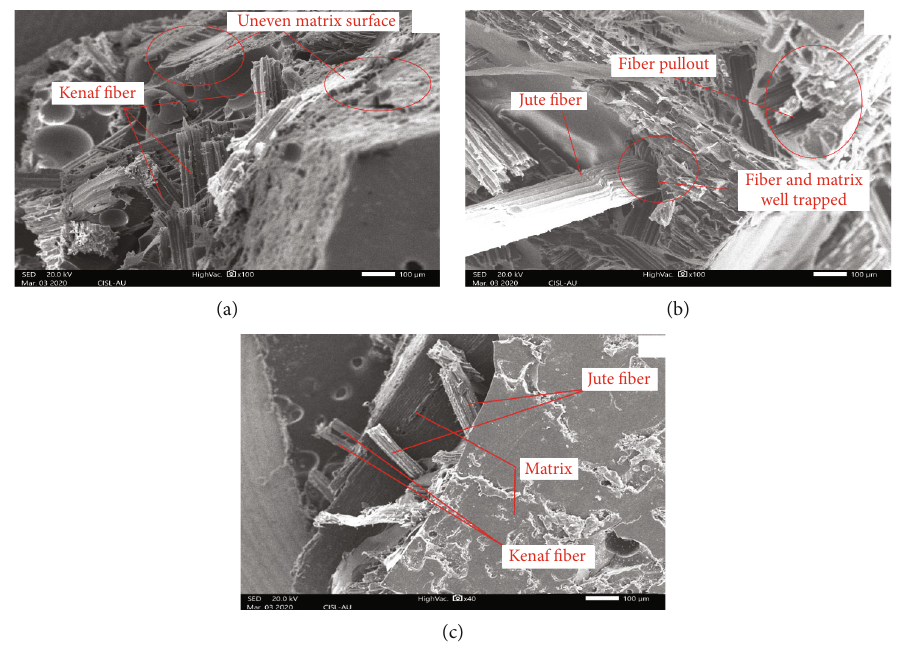
Figure 4: SEM image of a biocomposite fracture surface of fl exural strength, for (a) PR/KF, (b) PR/JF, and (c) PR/KJF2.